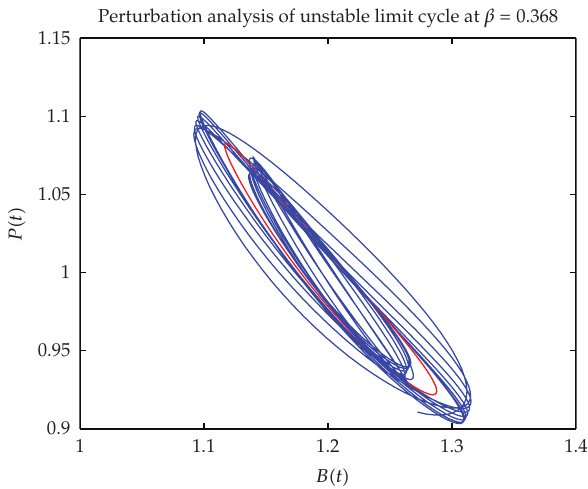
Figure 8: The unstable limit cycle (cid:5) red (cid:6) and the perturbation solutions (cid:5) blue (cid:6) for perturbations above and below the limit